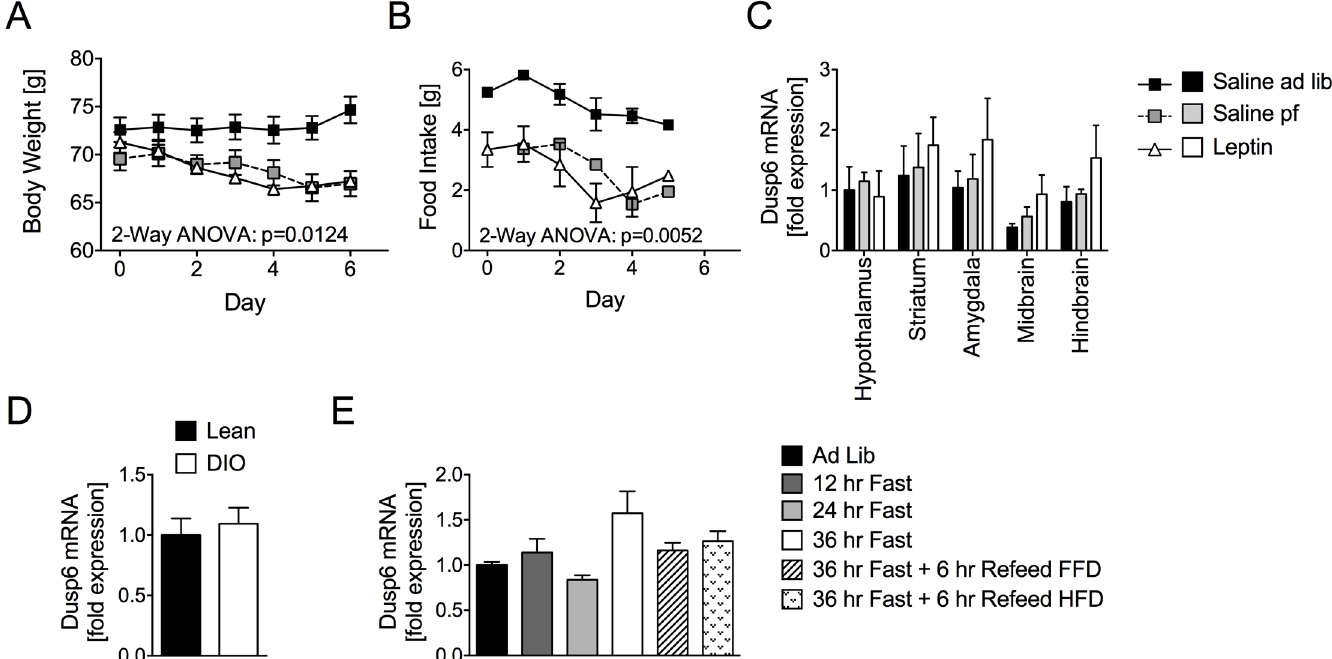
Fig 1. Central Dusp6 expressionis not affected by changes in body composition or nutrition. Decreasedbody weight (A) and food intake (B) but unchangedlevels of Dusp6 mRNA in brain areas (C) of chow-fedLep ob mice treated daily for 6 days with 1 mg/kg of leptin (Leptin) and chow-fedLep ob mice treated with salinebut pair-fed (Saline pf) to the Leptin group, comparedto ad libitum fed saline controls (Saline ad lib ) (n = 5–6 mice; food intake: n = 3 cages). Dusp6 mRNA levels were also assessedin (D) chow-fedlean vs. HFD-fed C57B/6J mice (n = 6–8), and in (E) chow-fedlean C57Bl/6J undergoingfasting or refeedingwith fat free or high-fat diet (FFD/HFD; n = 6–8). Means ± SEM.